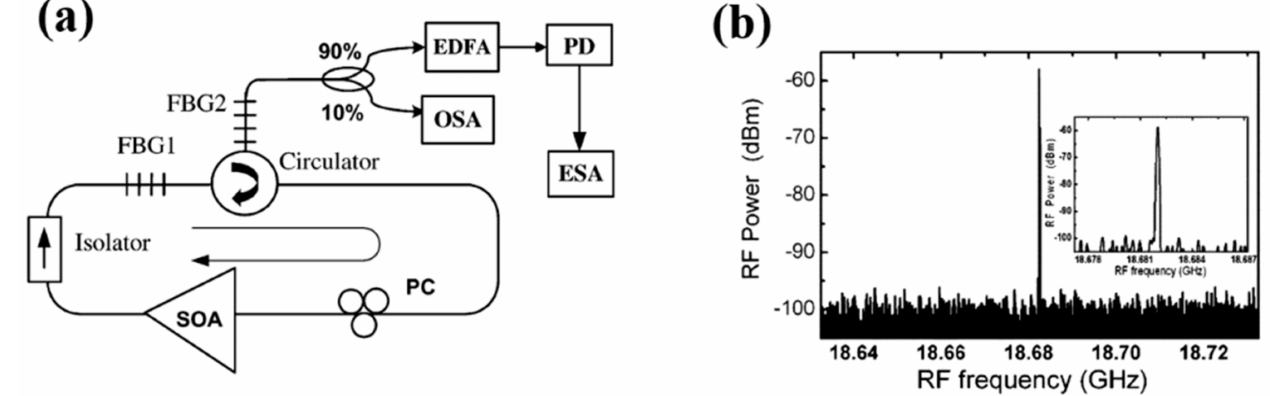
Figure 6. ( a ) Schematic diagram of the dual-wavelength SLM fiber ring laser and ( b ) electrical spectra of the generated microwave signal. Adapted with permission from ref. [57]. © [2022]